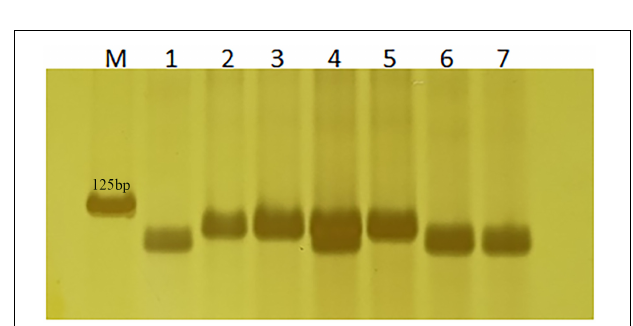
FIGURE 6 | Verification of Lr65 ’s diagnostic marker 1500-1. Nos. 1–3 are Altgold, Xuezao and CS. Nos. 4–7 are recombinants A523, A25, A321, and A211, respectively. M is